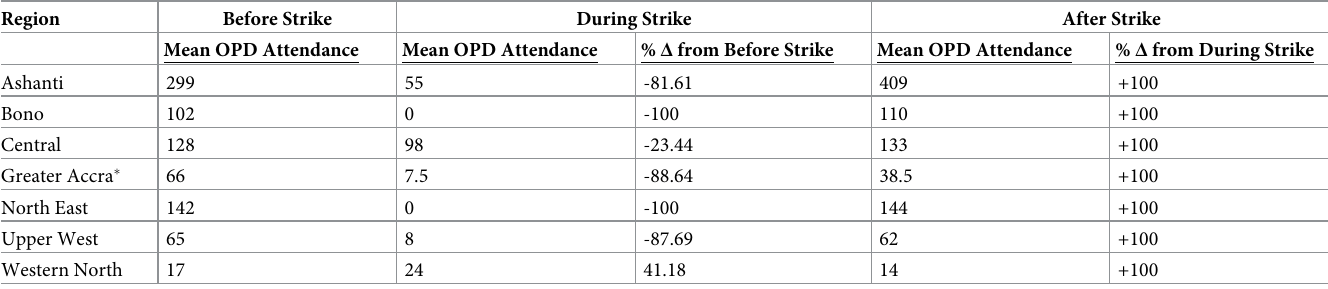
Table 8. Percentage change in outpatient department attendance during and after strike. Region Before Strike During Strike